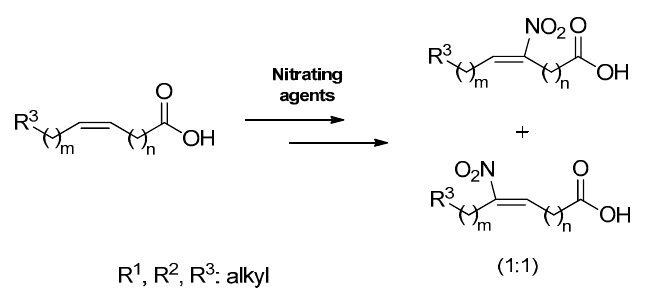
Figure 9. Gas-induced synthesis of nitro isomers and some of their characteristic 1 H-NMR shifts [101]. In 2000, D’Ischia studied the possible nitro products and by-products derived by the nitration of ethyl linoleate ( 27 ), yielding different isomers of nitroalkenes (Scheme 5).